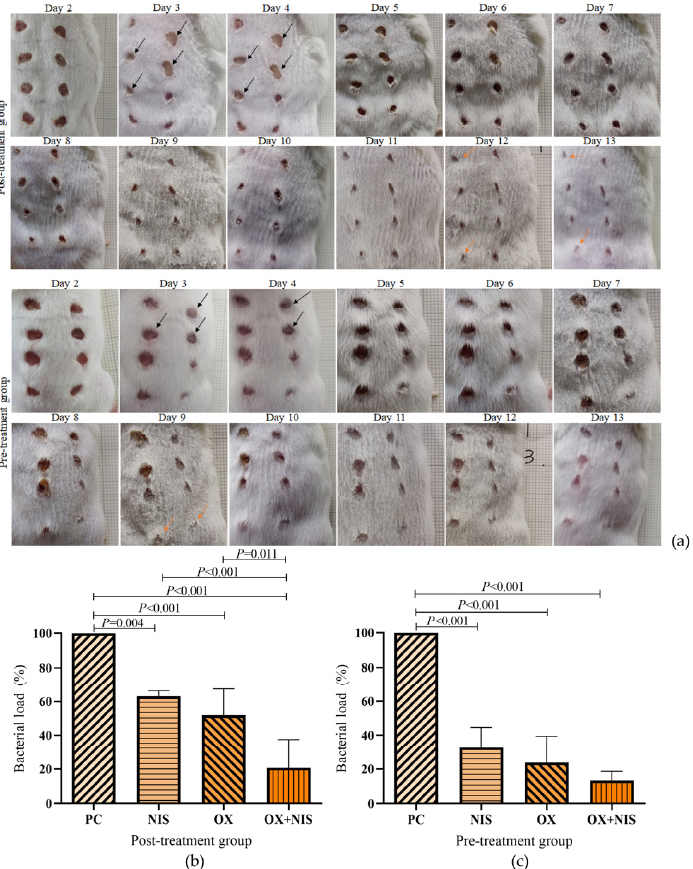
Figure 6. ( a ) Effects of post- and pre-treatment of OX and NIS alone and in combination on the healing of MRSA infected skin wound; At day 3, the bacterial load in MRSA infected skin wound were compared in post-treatment ( b ) and pre-treatment ( c ) of OX, NIS and OX + NIS. At day3, all treatments reduced the bacterial load both in post-treatment (Figure 6b) and pre-treatment (Figure 6c), as indicated by a reduced colony counts of Yn2020070 in the wound tissues. Compared with PC (100% survive), in pre-treatment wounds, MRSA strain had the survive rate of 23.61%, 32.54% and 13.36% in OX, NIS and OX + NIS; while in post-treatment, the survive rate was 62.97%, 51.91% and 20.67% respectively. Although the OX + NIS significantly inhibited the MRSA strain growth than PC, OX and NIS ( p < 0.001) in pre-and post-treatment, the bacterial loads in the pre-treatment arelower than the corresponded